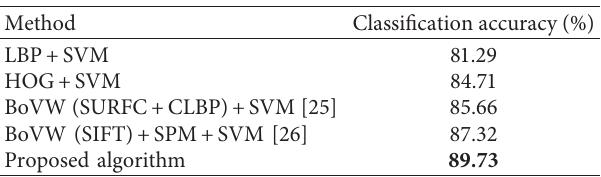
Table 1: Comparison with other image classification methods on Microsoft PI100